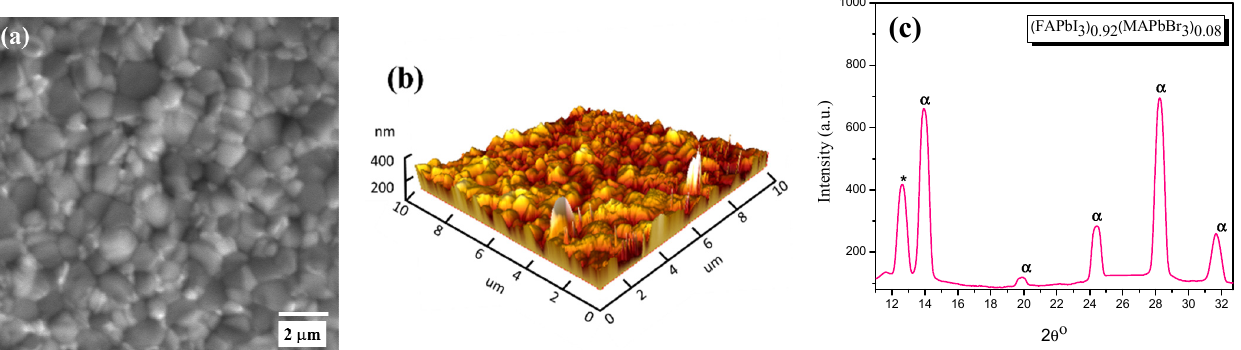
Figure 2. ( a ) SEM and ( b ) AFM microphotography and ( c ) XRD of the perovskite thin film. The homogenous distribution of the nanocrystals on the surface of the substrate is presented by AFM 3D image. XRD spectra peaks for (FAPbI3)0.92(MAPbBr3)0.08 deposited on the quartz substrate. The crystallinity structures were supported by XRD measurement of the thin films.